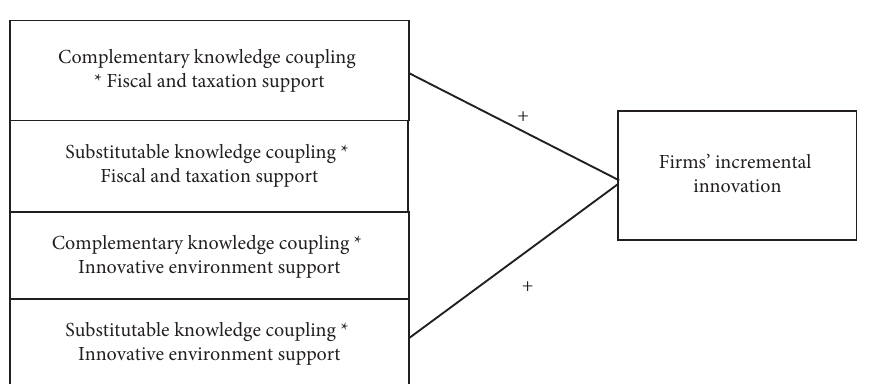
Figure 3: The fitness model of government support and knowledge coupling.